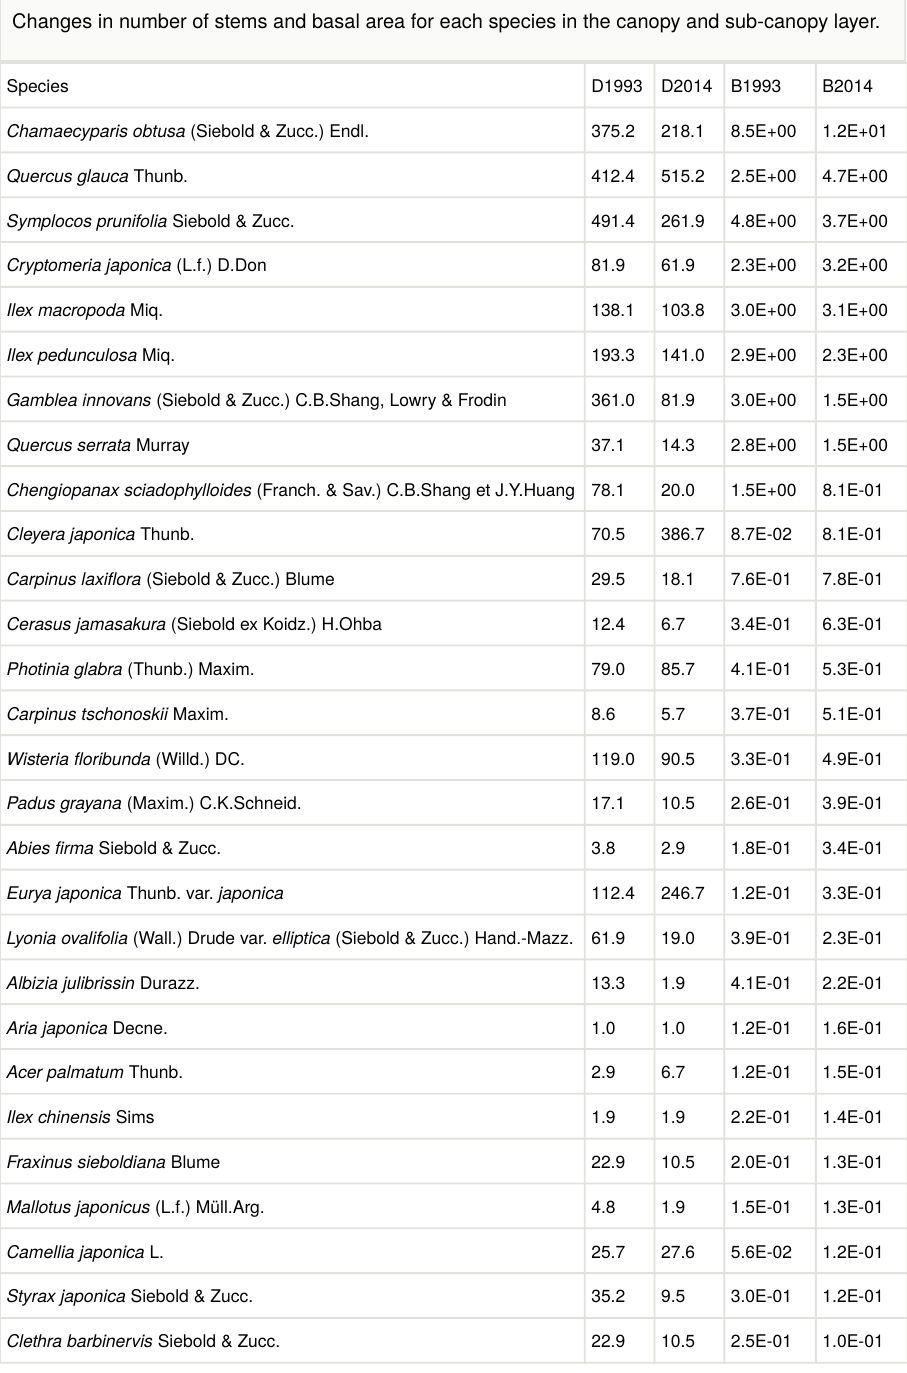
Table 1. Changes in number of stems and basal area for each species in the canopy and sub-canopy